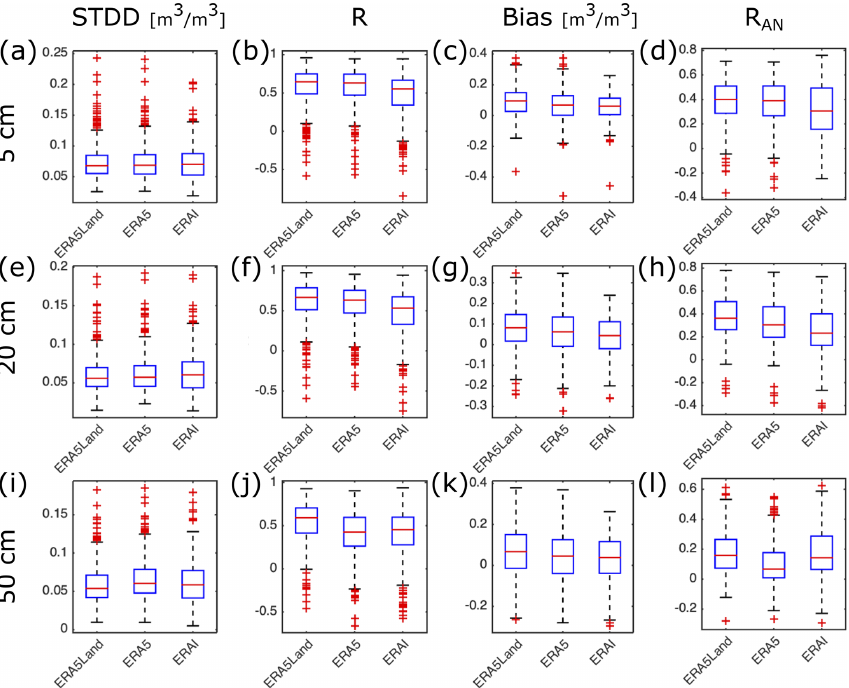
Figure 7. Box plots showing the evaluation of ERA5-Land, ERA5, and ERA-Interim against in situ measurements at 5 (a–d) , 20 (e–h) , and 50cm (i–l) over North America. Panels (a) , (e) , and (i) show the standard deviation of the difference (STDD), (b) , (f) , and (j) the Pearson correlation, (c) , (g) , and (k) the bias, and (d) , (h) , and (l) the Pearson correlation of the anomaly time series ( R AN ). On each box, the central mark indicates the median, and the bottom and top edges of the box indicate the 25th ( q 25 ) and 75th ( q 75 ) percentiles, respectively. The whiskers extend to the most extreme data points not considered outliers.